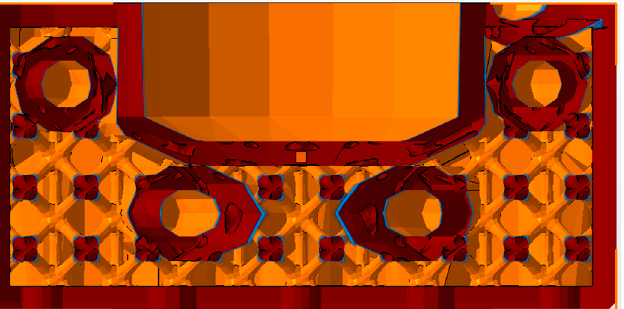
Figure 8. Section through the shaped intermediate piece with internal structure in the shape of the star .